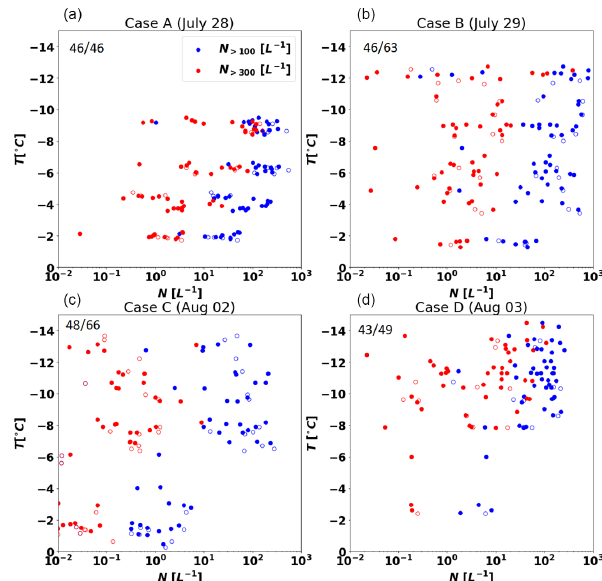
Figure 3. Median hydrometeor concentrations for all particles with D > 100m (blue) and D > 300m (red) at the corresponding tem- perature levels for all penetrations for the four cases. Open circles represent those penetrations that meet the criteria for an updraft core (see text) and closed circles those that do not. The fractional num- ber in panel (a) of each graph represents the number of penetrations with median N > 10 − 2 L − 1 . The denominator indicates the total number of penetrations from that